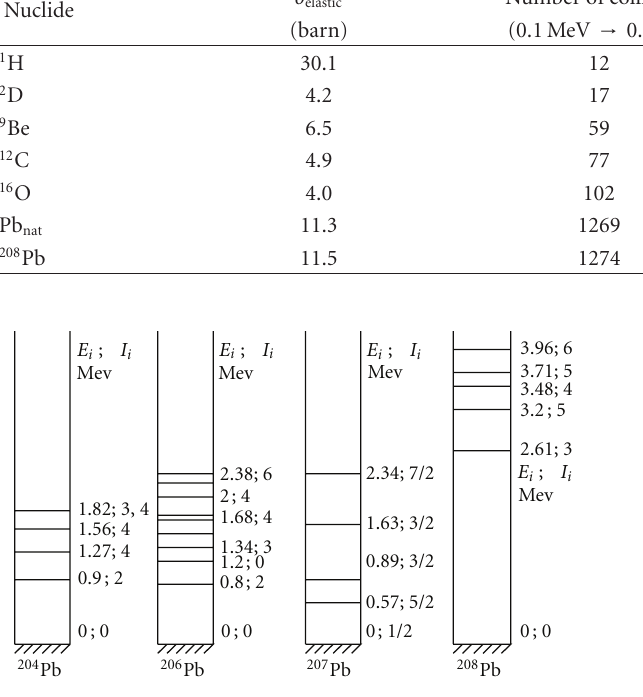
Figure 1: The excitation levels of lead nuclides.